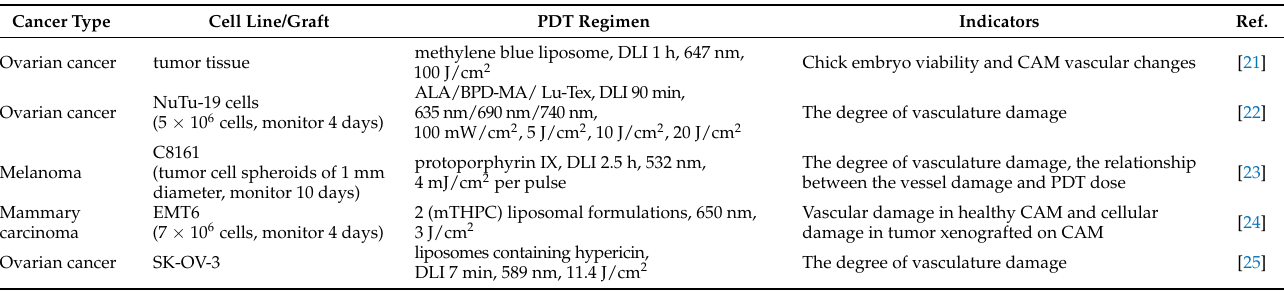
Table 1. Application of CAM in antitumor study of